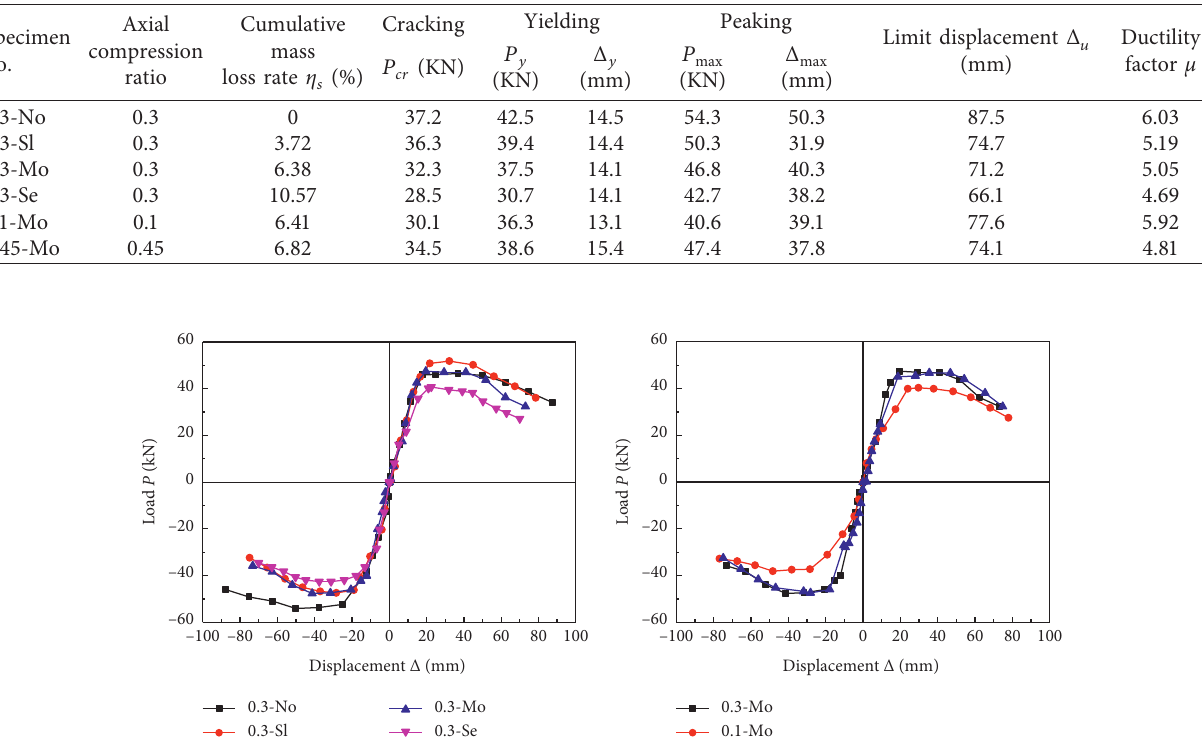
Figure 7: Hysteretic curves of specimens. (a) 0.3-No. (b) 0.3-Sl. (c) 0.3-Mo. (d) 0.3-Se. (e) 0.1-Mo. (f) 0.45-Mo. Table 5: Test results of specimens.